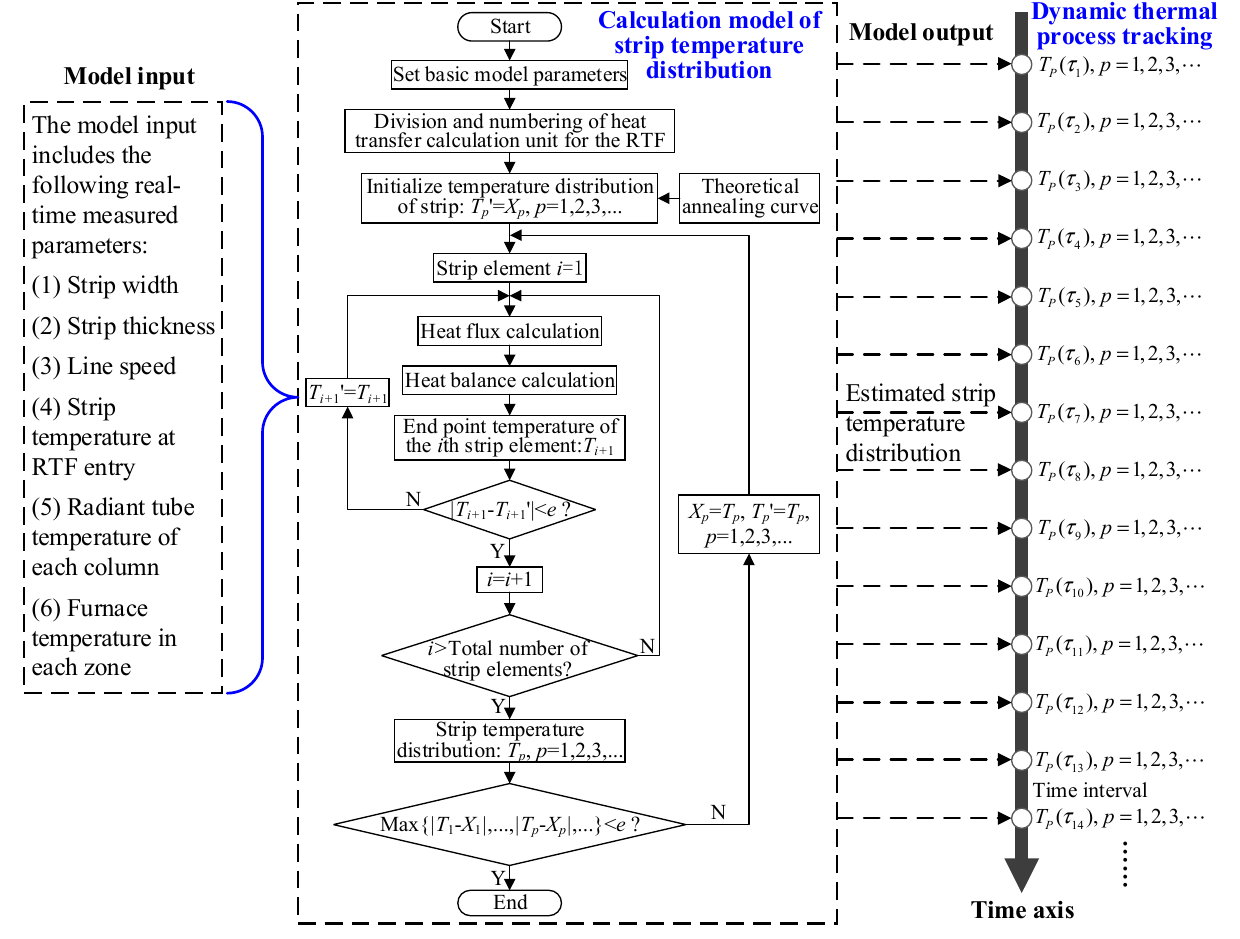
Figure 3. Flow diagram of calculation and tracking of strip temperature distribution in the RTF.